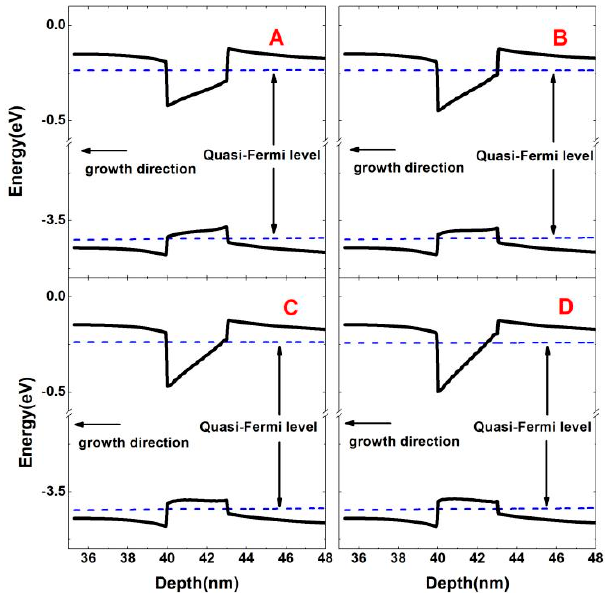
Figure 4. Energy band of the last well of samples A , B , C and D .